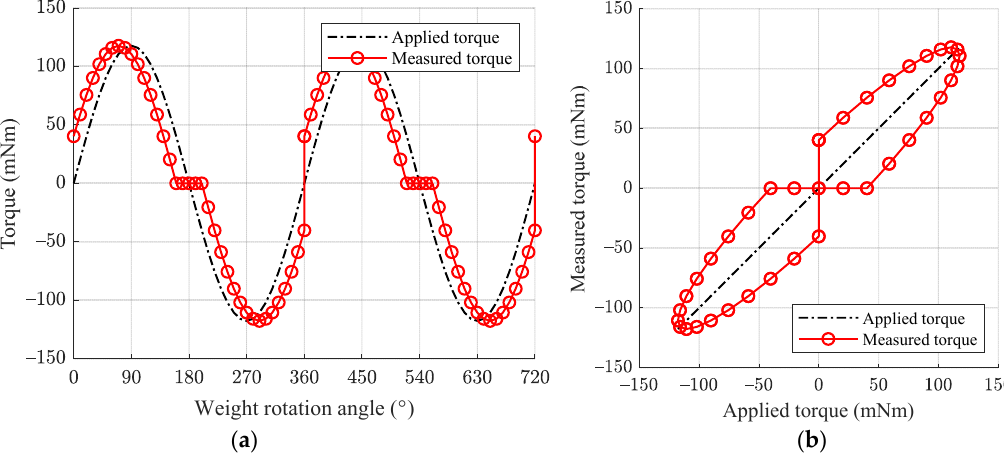
Figure 13. The e ff ect of actuator backlash on output torque in continuous torque measurement: 10 ◦ sampling interval, 40 ◦ actuator backlash and 117.2 mNm maximum input torque. Resultant torque root mean square errors (RMSE) is 27.88 mNm. The x -axis is ( a ) the input rotation angle and ( b ) the converted